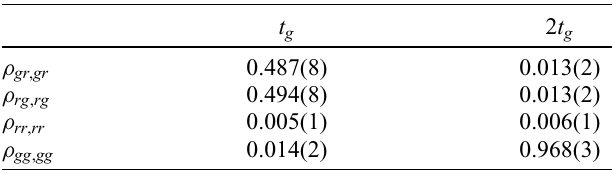
TABLE III. The two-atom basis populations for the lowest three values of I c at t g and 2 t g used to calculate the fidelity from Eq. C1. t g 2 t